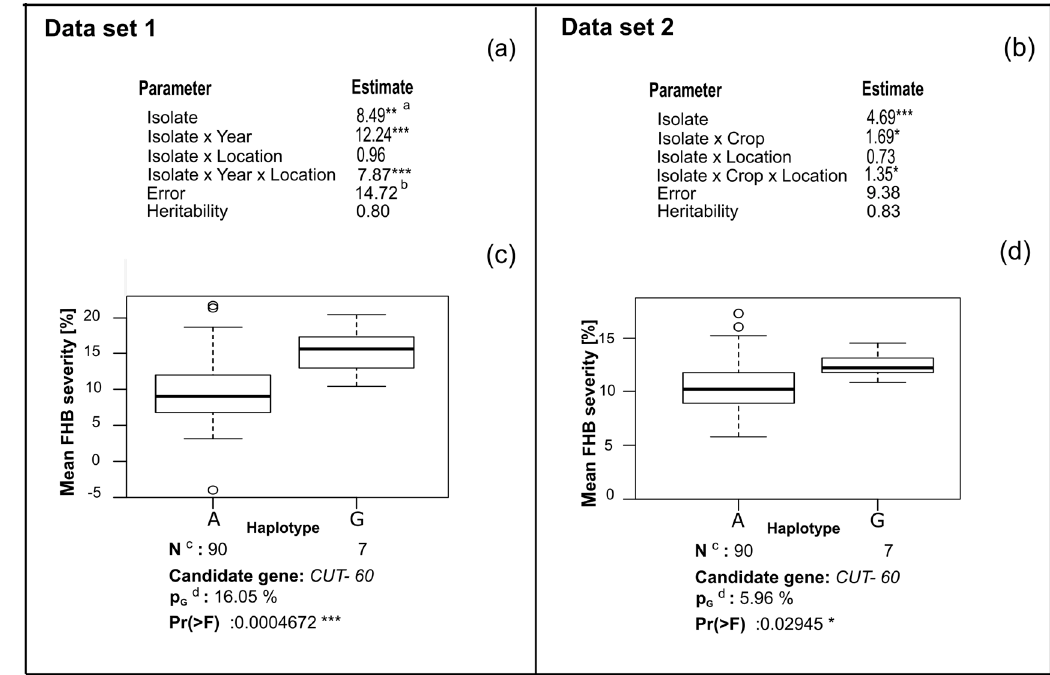
Figure 5. Estimates of variance components ( a , b ) and boxplots for mean FHB severity (%) among the two haplotypes of the associated SNP ( c , d ), significances and percentages of genotypic variance explained by CUT - 60 (p G ) in Data set 1 (rye in 2015 + 2016) and Data set 2 (rye+wheat in 2015) after inoculation with 100 Fusarium culmorum isolates (Table S1). a *** Significance at p < 0.001, ** significance at p < 0.01, * significance at p < 0.05; b Since heterogeneous variance for error was assumed, the reported value is the mean value of the individuals errors, c Number of isolates representing the haplotypes, d Percentage of the genotypic variance explained.